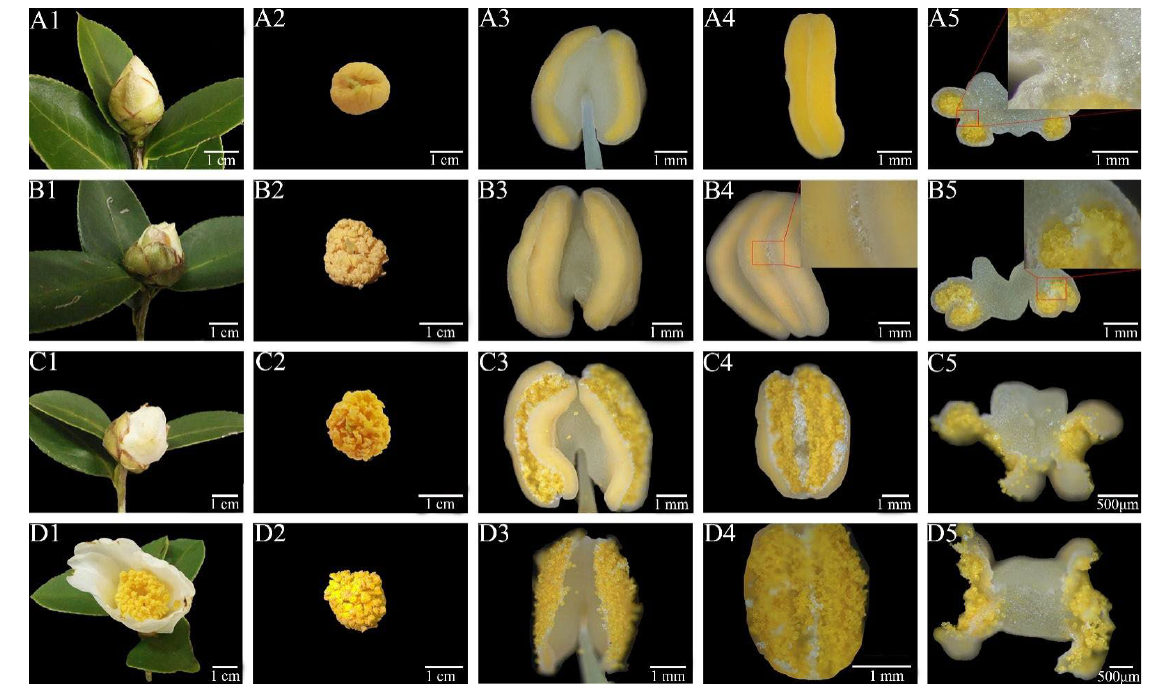
Figure 1. Single flower opening and anther dehiscence in Camellia oleifera. ( A1 – D5 ): cross-sections of flower buds, stamens, single anthers, anther stomia, and anther cross-sections of C. oleifera in the early flowering phase ( A1 – A5 ), when sepals but not petals unfolded ( B1 – B5 ), when petals were exposed ( C1 – C5 ), and when blooming ( D1 – D5 ).